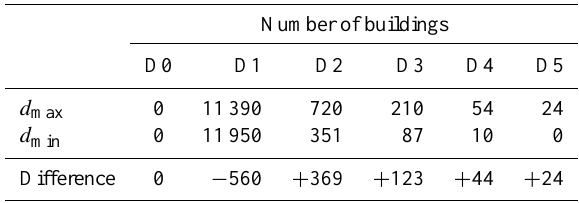
Table 7. Maximum and minimum number of buildings attributed to each level of damage. Notice that the number of buildings shown in the last row of Table 6 lies in between the ones of this table. Data have been computed for simulations carried out for the case of mean-sea-level conditions.